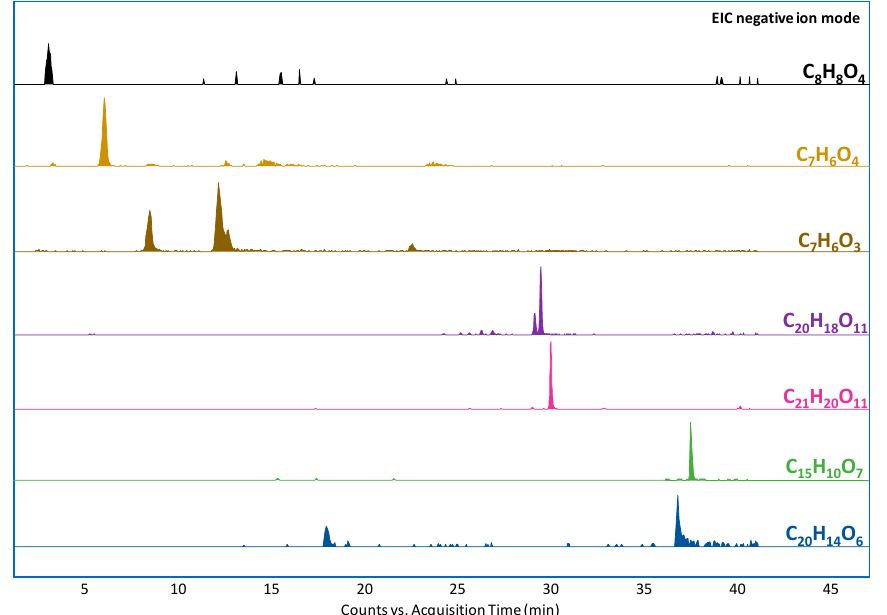
Figure 6. Extracted ion chromatograms from the extract of the nonaged yarn dyed with walnut and without mordant. The molecular formulas correspond to vanillic acid (C 8 H 8 O 4 , m/z 167.0350), 3,4-dihydroxybenzoic acid (C 7 H 6 O 4 , m/z 153.0193), 4-hydroxybenzoic acid and 3-hydroxybenzoic acid (C 7 H 6 O 3 , m/z 137.0244), quercetin 3-galactoside and quercetin 3-rhamnoside (C 20 H 18 O 11 , m/z 433.0776), quercetin 3-arabinoside and quercetin 3-xyloside (C 21 H 20 O 11 , m/z 447.0933), and juglone dimer (C 20 H 14 O 6 , m/z 349.0718, tentative attribution).